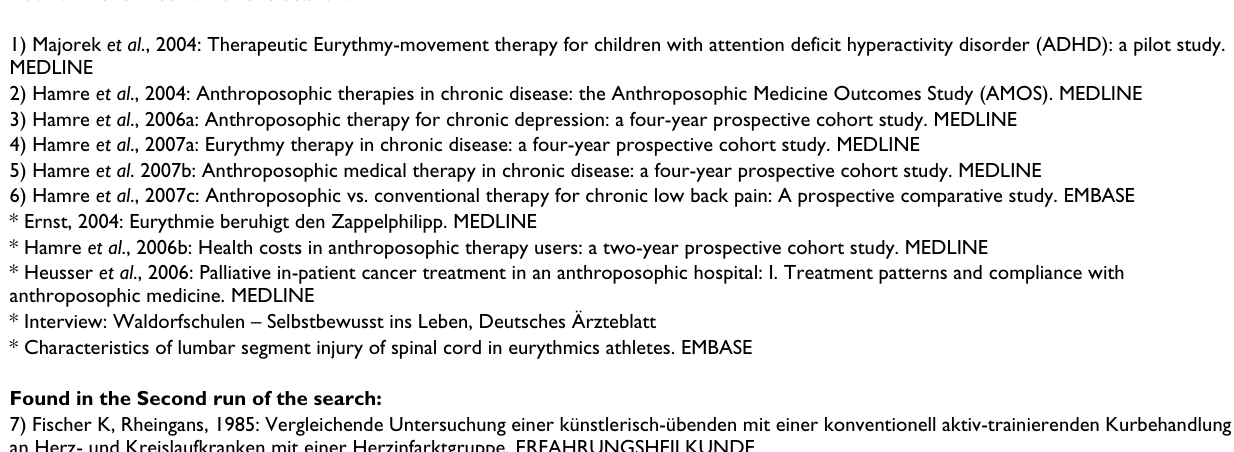
Table 1: Citations of the term eurythmy found in the databases and their source Found in the first run of the